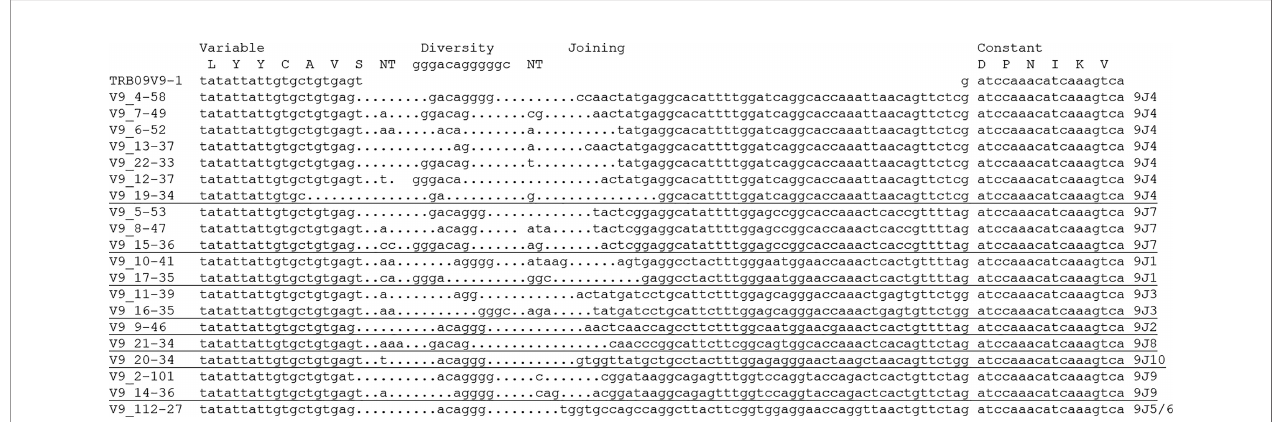
FIGURE 5 | Alignment of CDR3 region for selected expressed TRB09V9 sequences. Variable, diversity, joining and constant regions are shown above the alignment. Non-genome nucleotide insertions are shown in the regions denoted NT. Dots indicate missing sequence. Individual TRB09 joining elements used are shown on the right hand side where we cannot decipher between 9J5/9J6 as they are completely identical. Names of expressed reads, for instance V9_4-58, indicate Variable subgroup 9, collapsed read number 4 supported by 58 sequences with 100% nucleotide sequence identity.